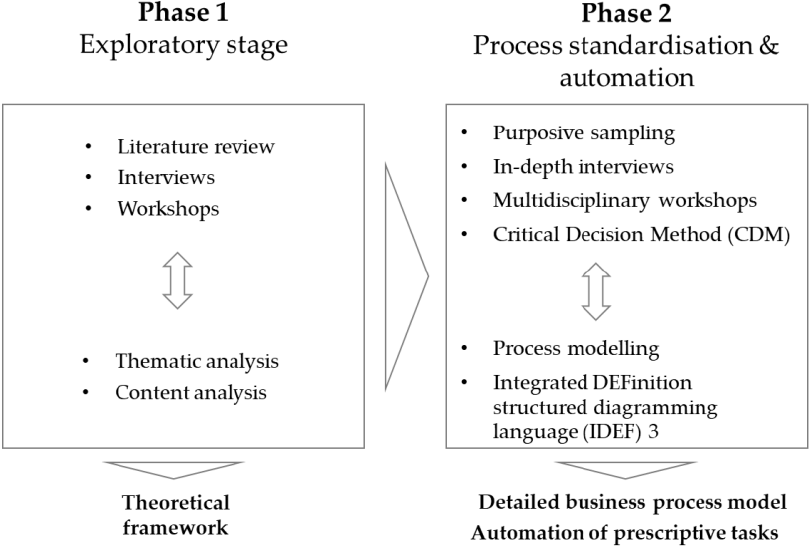
Figure 1. Research strategy and methods used.